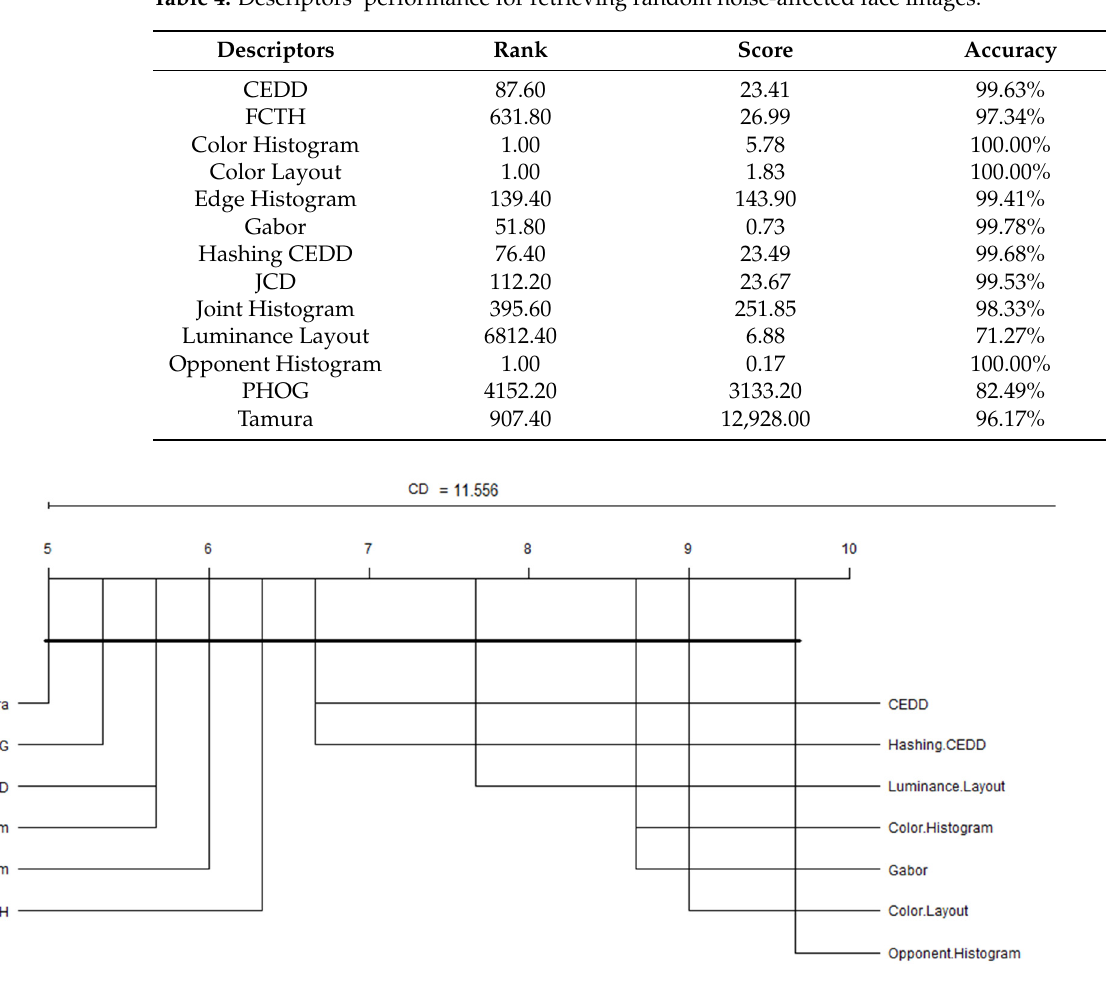
Figure 12. Critical Distance Diagram (CDD) for random noise-affected face images.